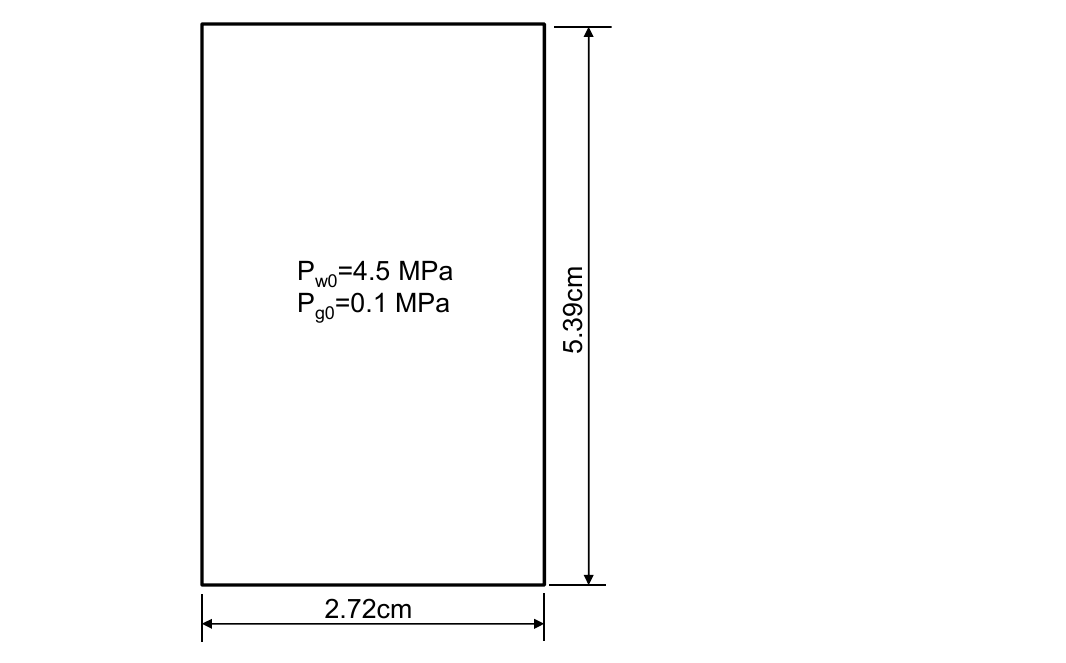
Figure 6. Geometry of breakthrough test problem. Table 1. Langmuir pressure and strain in gas breakthrough test.